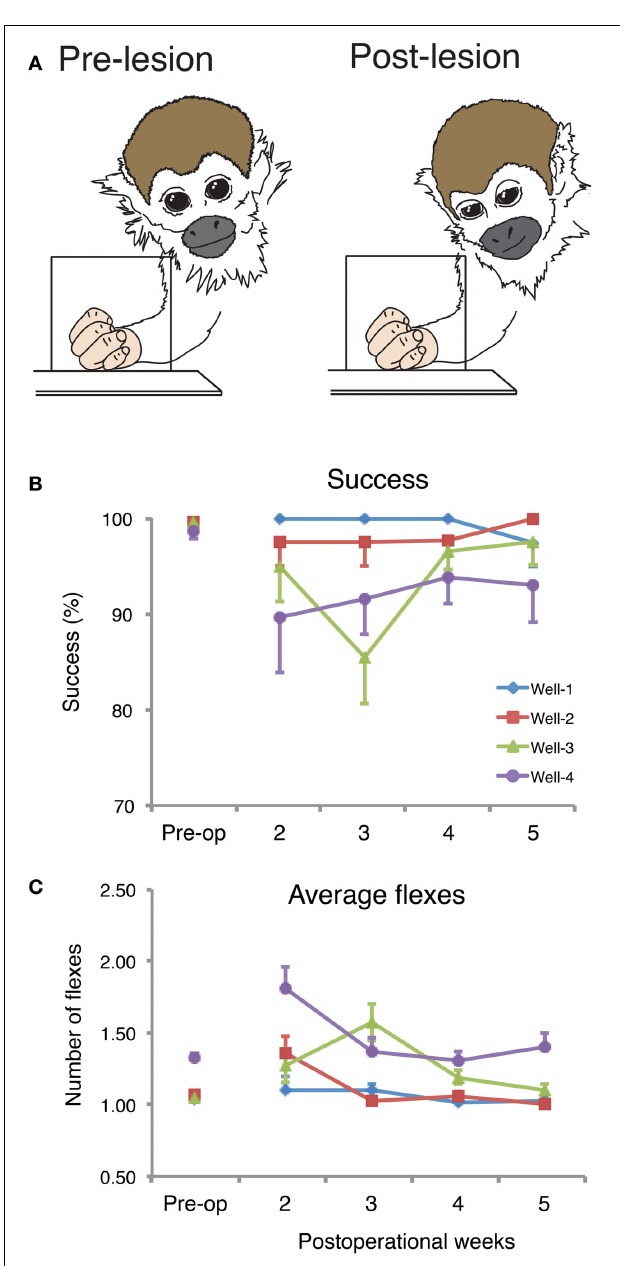
FIGURE 5 | Spontaneous recoveries after dorsal column injury can be incomplete or incorporate various compensations. (A) Drawings from the captured photo-frames taken from a squirrel monkey (SM-O) during the reach-to-grasp task pre-lesion (left) and on post-op Day 15 (right). The schematic summarizes observations that after the spinal cord lesion, monkeys compensate for reduced tactile sensation by relying more often on vision. (B) Post-operational changes in the percentage of successful retrievals (mean, ± SD ) in the reach-to-grasp task. Success scores in percent of the retrieval success for summed trials from each of the 4 testing wells per post-op week for monkey SM-O. Pre-op final week trials were summed. (C) Post-operational changes in mean number of flexes (mean, ± SD ) for monkey SM-O. Each data point within each panel is the averaged number of flexes from the sum of the trials from each of the 4 wells over each testing week. Adapted from Qi et al.